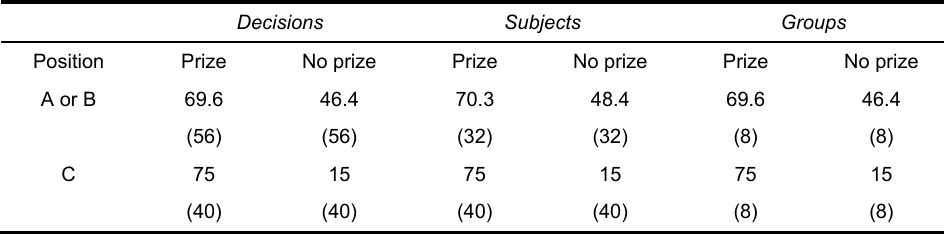
Table 2: Average percentage of contributions, contingent on position (A/B or C) and treatment (prize or no prize) Decisions Subjects Groups Position Prize No prize